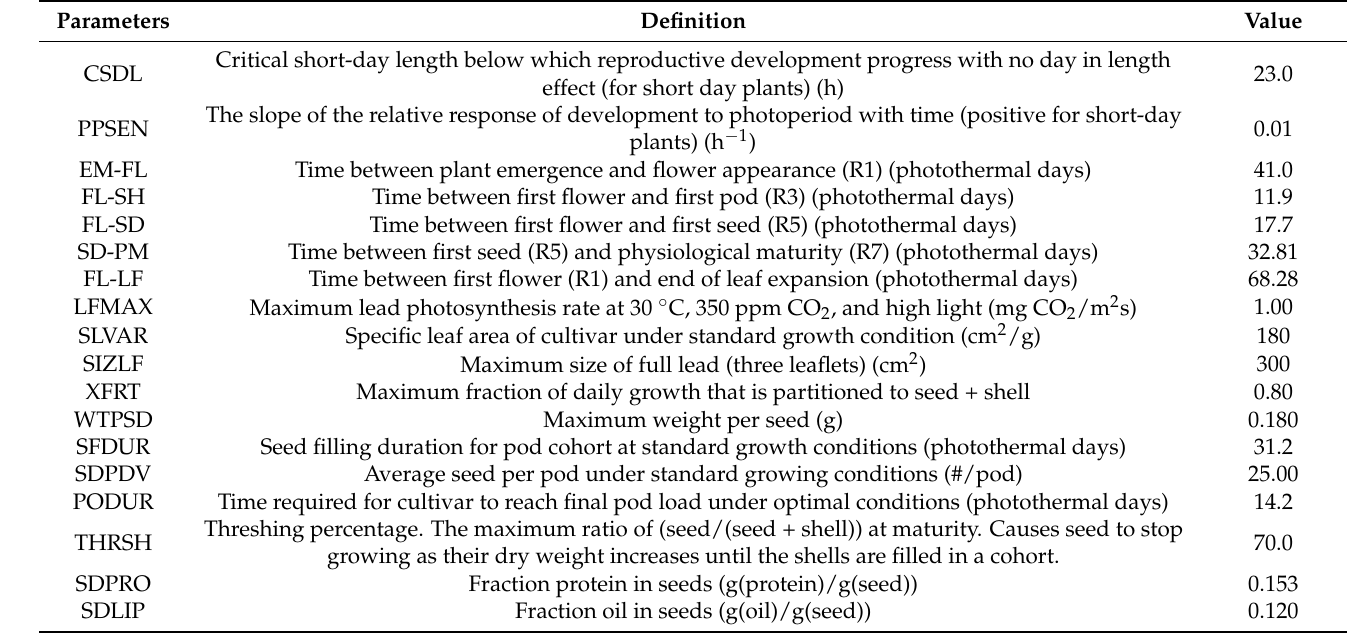
Table 2. Cultivar parameters used for simulating cotton (cv. Deltapine Land 1522) using the CSM- CROPGRO-cotton v4.6.